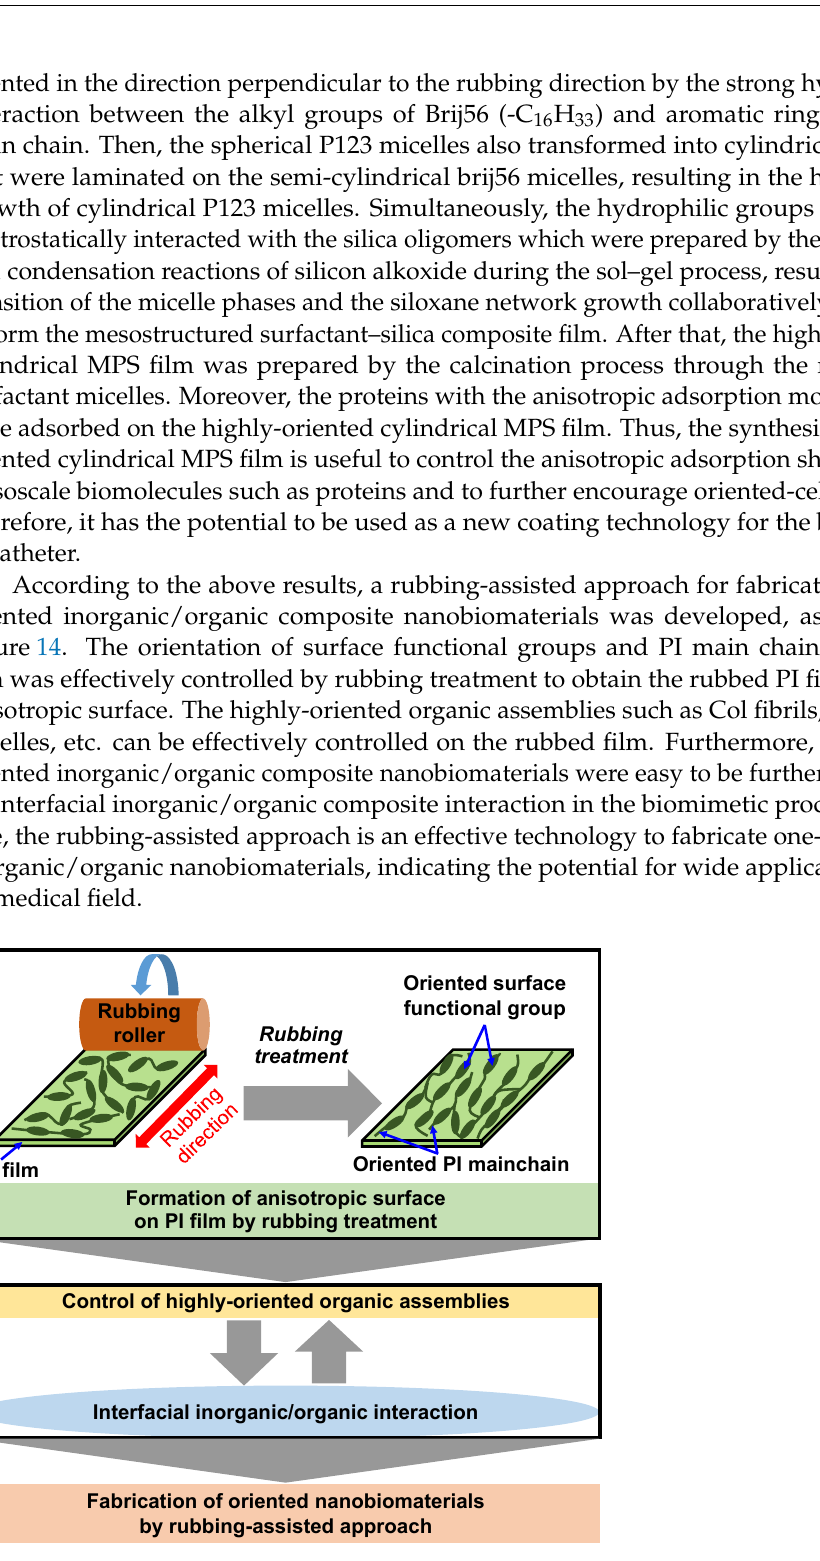
Figure 14. Scheme of rubbing-assisted approach for fabricating oriented nanobiomaterials.